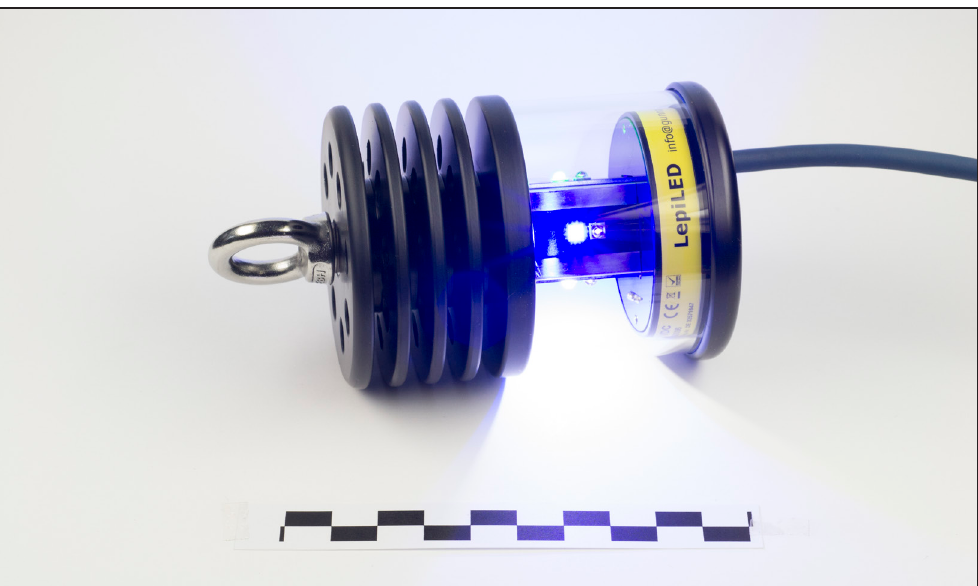
Figure 8. First exemplar of the commercially available lamp “LepiLED”, height ca. 88 mm, diameter ca. 62 mm. Scale bar: 10